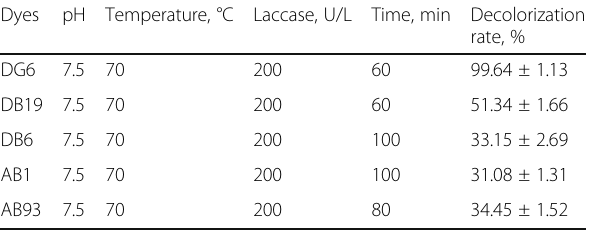
Table 2 The conditions of dyes oxidized with LacAn Dyes pH Temperature, °C Laccase, U/L Time, min Decolorization